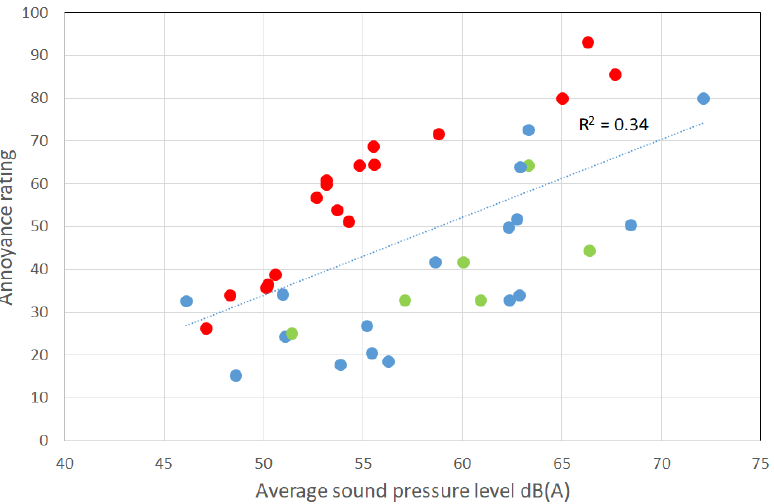
Figure 4. The relationship between perceived annoyance ratings and sound pressure level in dB(A). Different colors are used in the figure to represent three different passenger car types. Color representation is also used in the Figures 5–8. Red dots correspond to the internal combustion engine cars, green dots represent the hybrid cars, and blue dots represent the electric cars.